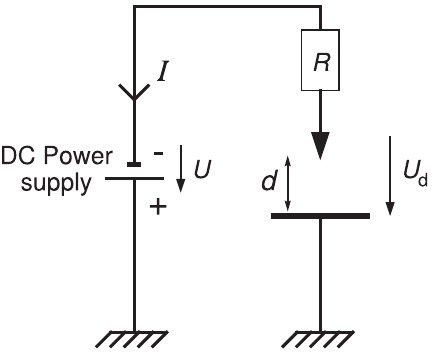
Figure 1. Schematic representation of a negative point-to- plane discharge with metallic electrodes – three-dimensional setup. 100 l m (cid:3) d (cid:3) 3 mm, R = 23 M X